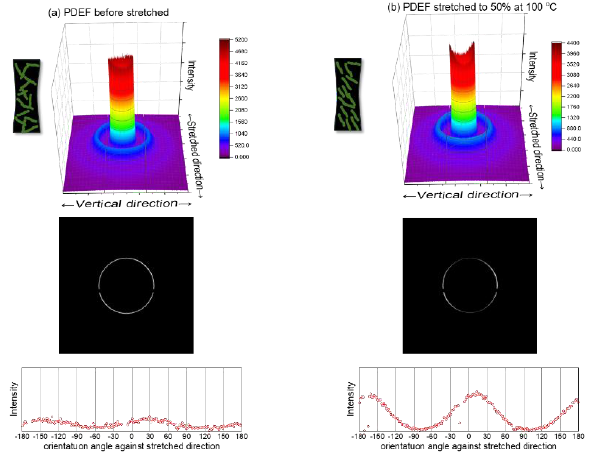
Figure 7. WAXS profiles of PDEF ( a ) before and ( b ) after the 50% extension at 100 °C. ( Top ) Three- dimensional plot, ( middle ) two-dimensional plot, and ( bottom ) the intensity profile in the azimuthal angle are displayed. The intensity is in the arbitral unit.